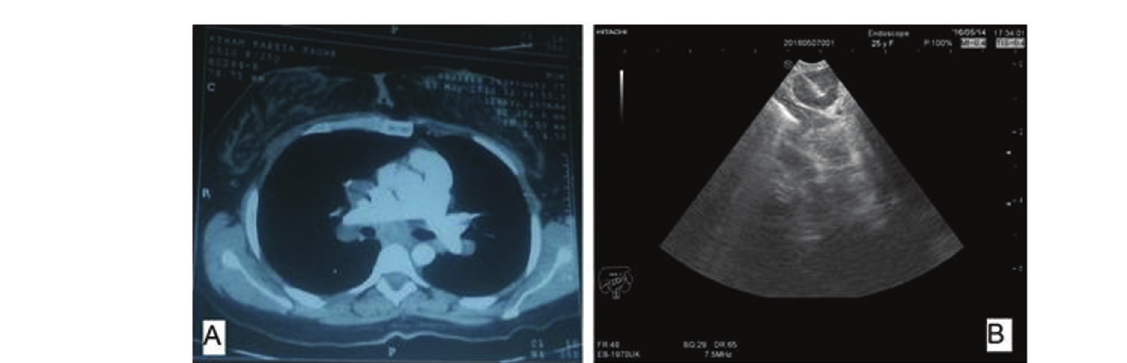
A25yearfemalepatientcomplainedfromdyspneaandnonproductivecough.(a)Computedtomographyscanshowsalargesubcarinallymphnode (station 7). (b) Endobronchial ultrasound-guided transbronchial needle aspiration was done, diagnosed as lymphoblastic non-Hodgkin